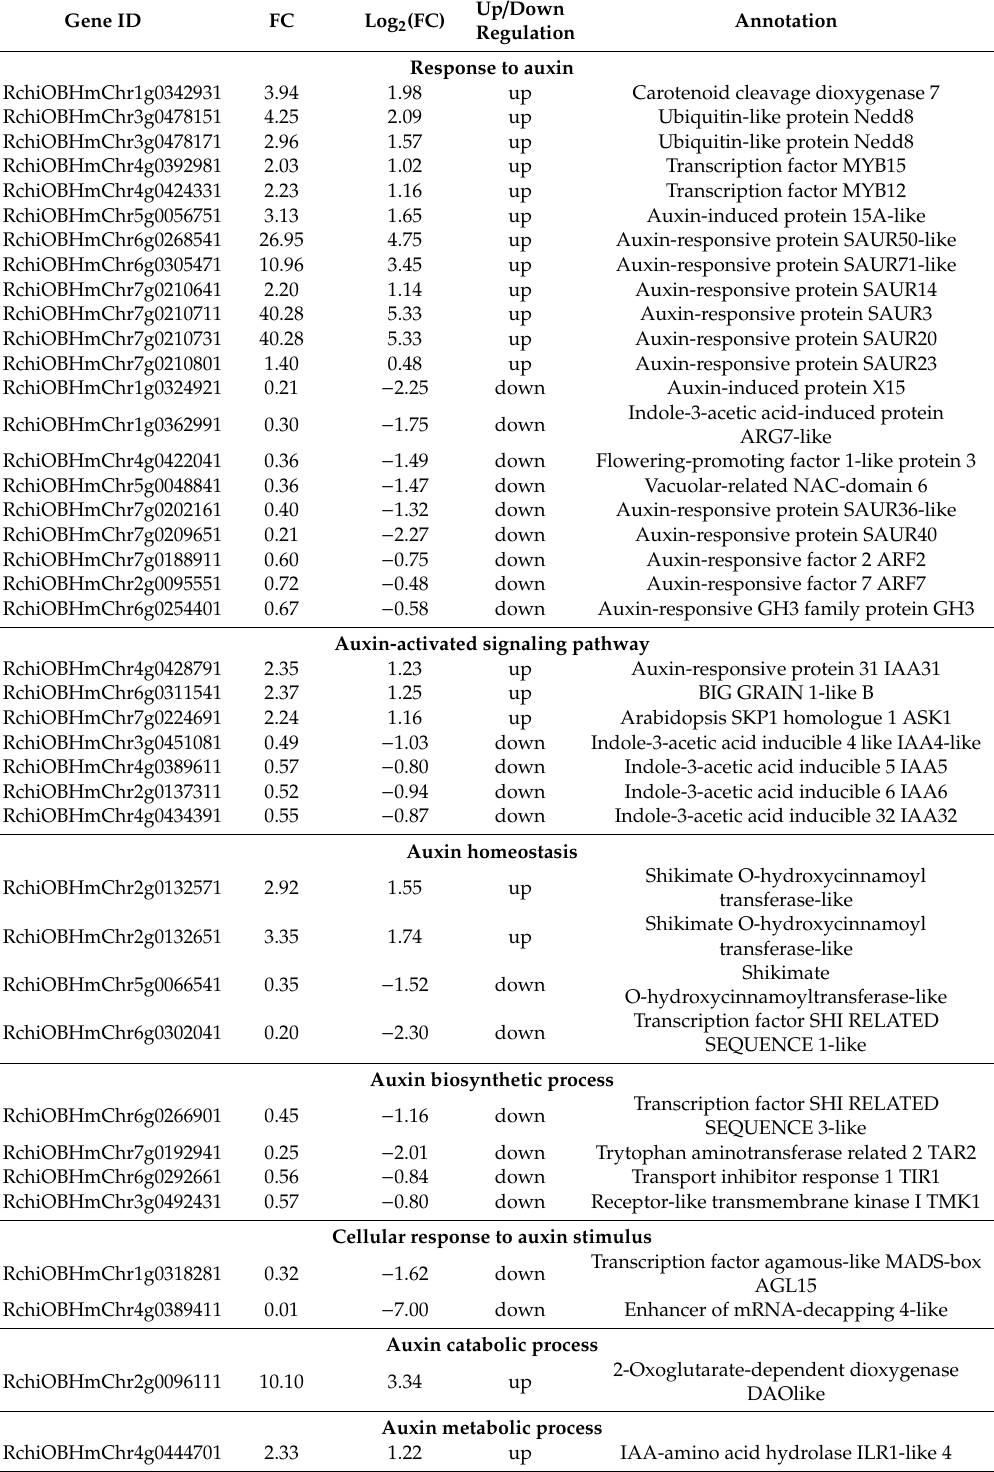
Table 2. DEGs involved in the auxin